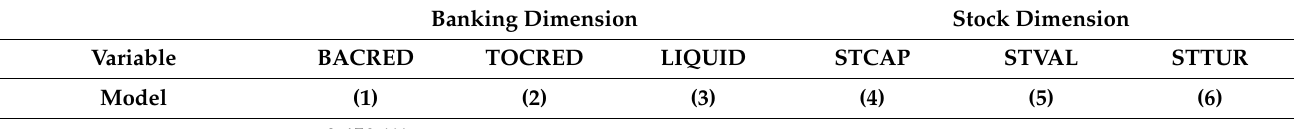
Table 8. The regression results of the impact of FDI on financial development during non-crisis years. Banking